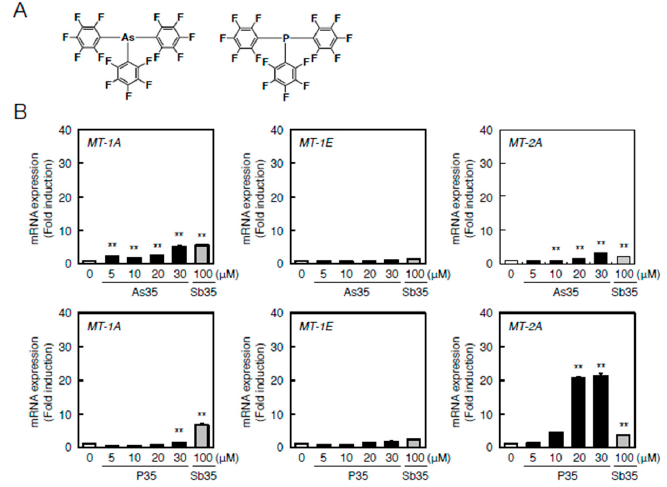
Figure 6. As35 or P35-induced transcription of endothelial MT-1A , MT-1E , and MT-2A . ( A ) Structures of As35 and P35; ( B ) Endothelial MT-1A , MT-1E , and MT-2A expression after As35 ( upper panels) or P35 (lower panels) treatment. Vascular endothelial cells were treated with or without 10, 20, 50, or 100 µM As35 for 12 h (upper panels) or 5, 10, 20, or 30 µM P35 or 12 h ( lower panels). The cells were also treated with 100 µM Sb35, which served as a comparative control. MT-1A , MT-1E , and MT-2A mRNA expression was determined by performing real-time RT-PCR. Data are expressed as the mean ± SE of three representative samples, with each sample obtained from three independent experiments. ** p < 0.01 indicate significantly different from the corresponding control.